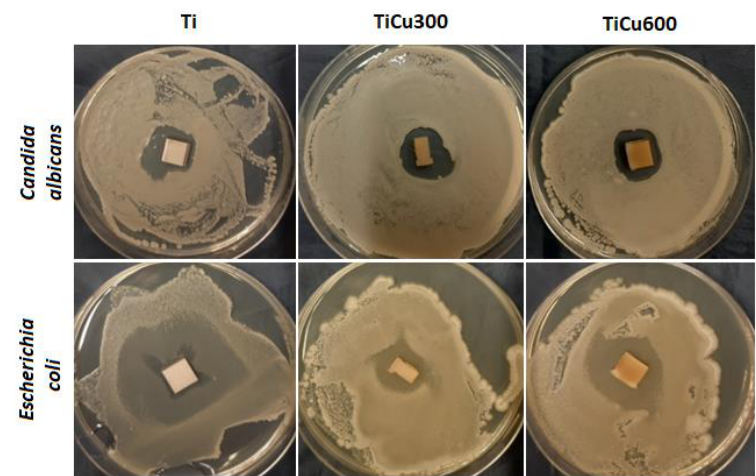
Figure 9. Sensitivity assessment of tested microorganisms applied on coatings.